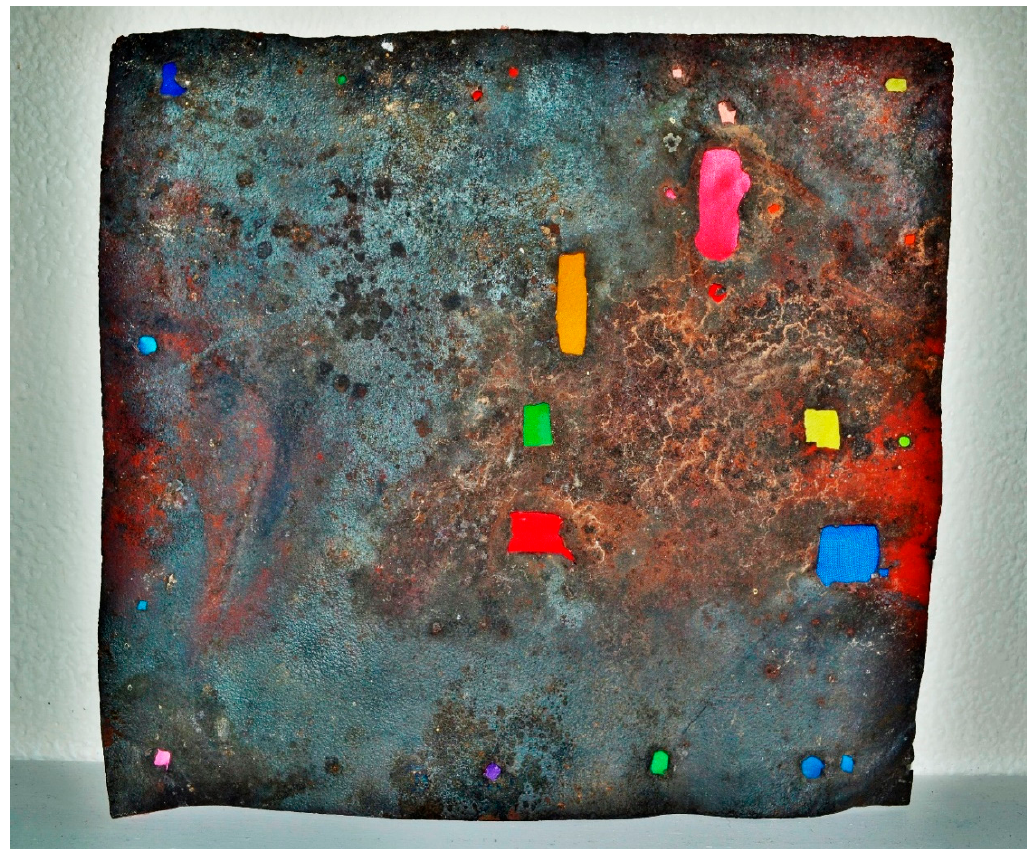
Figure 8. Notte in Oman. Photo by Agricubismo ® .